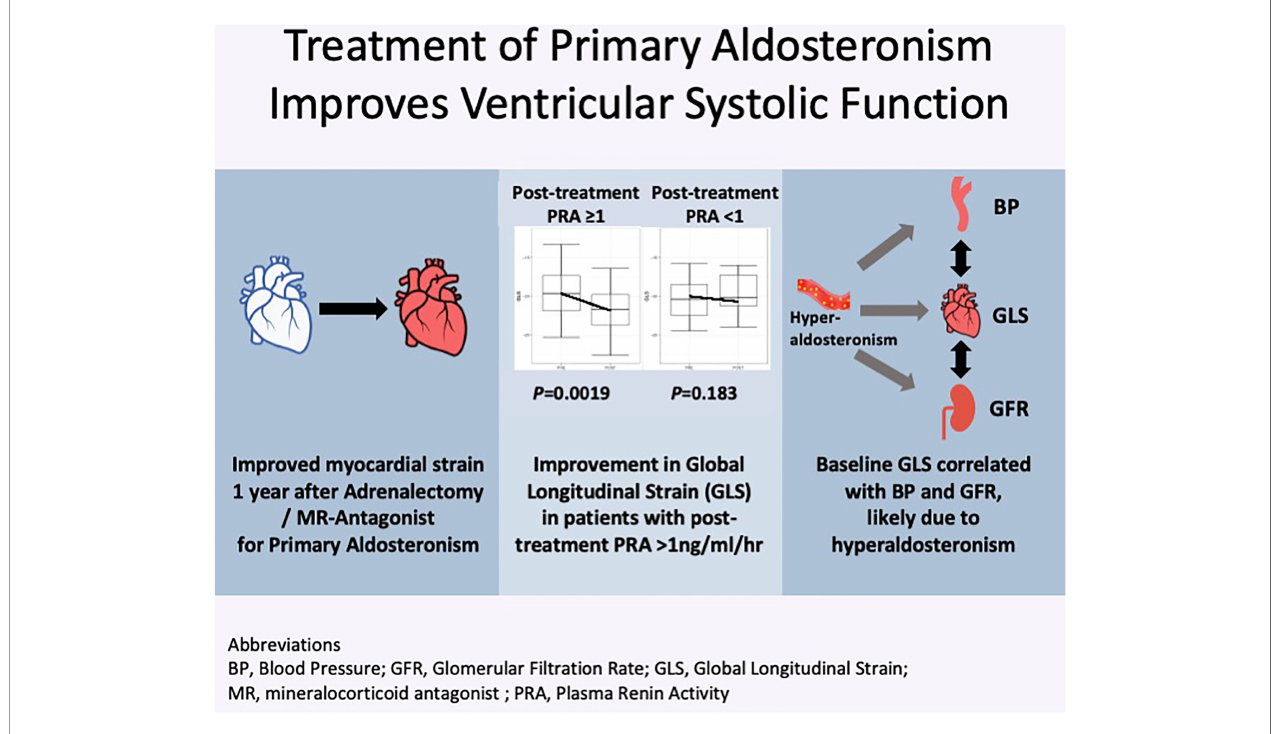
FIGURE 5 | Visual